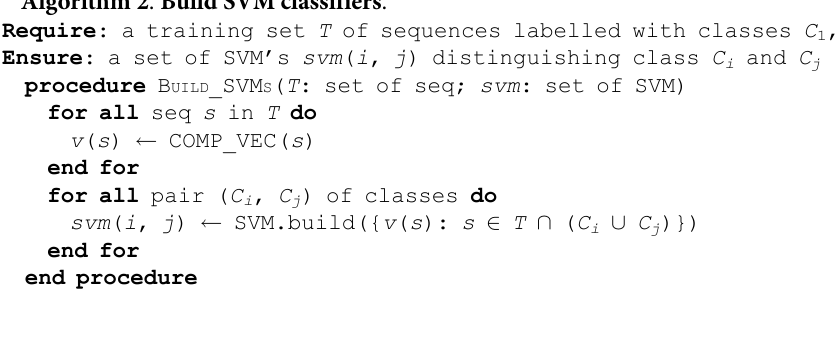
Algorithm 2 . Build SVM classifiers .